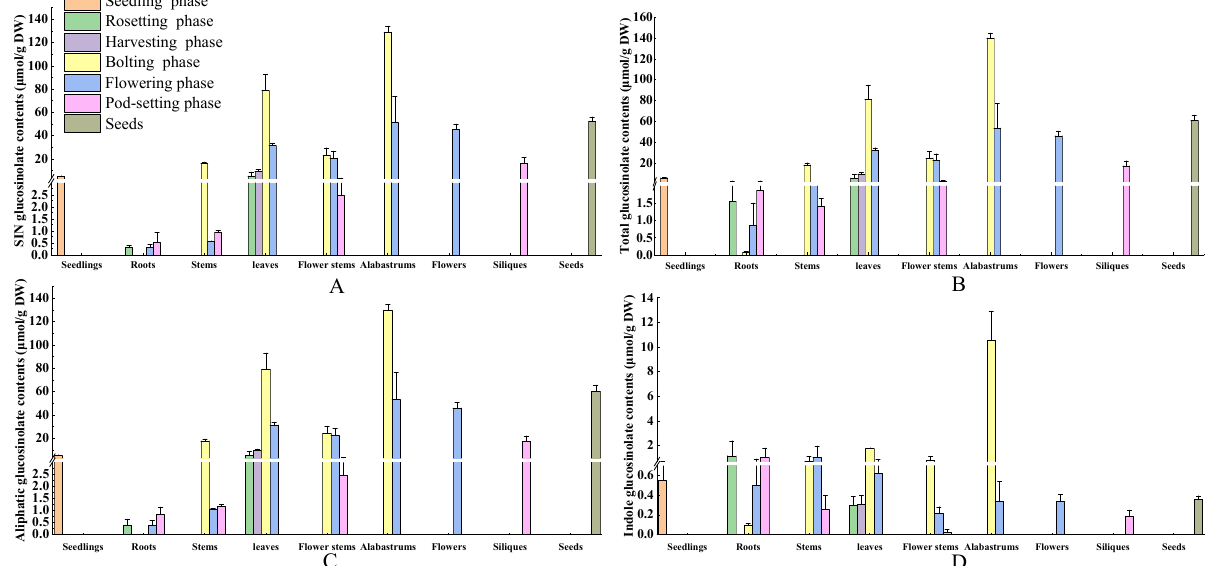
Figure 7. Differential distribution of glucosinolates among different periods in the same part in mustard JC 18-56. The sinigrin glucosinolate contents ( A ), total glucosinolate contents ( B ), aliphatic glucosinolate contents ( C ), indole glucosinolate contents ( D ) of the seedling phase, rosetting phase, harvesting phase, bolting phase, flowering phase, pod-setting phase in the whole plant, root, leaf, stem, flower stem, alabastrum, flower, silique, and seed tissues.